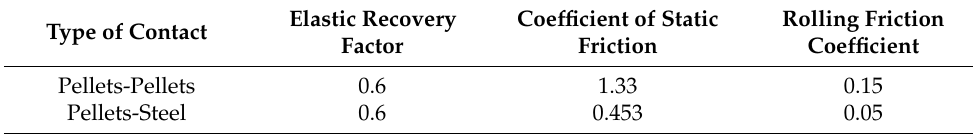
Table 8. The contact properties.